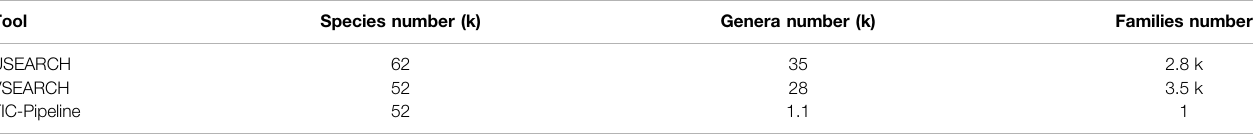
TABLE 4 | Diversity estimations among the three tools for the Bi fi dobacteriaceae sequences extracted from IMNGS.